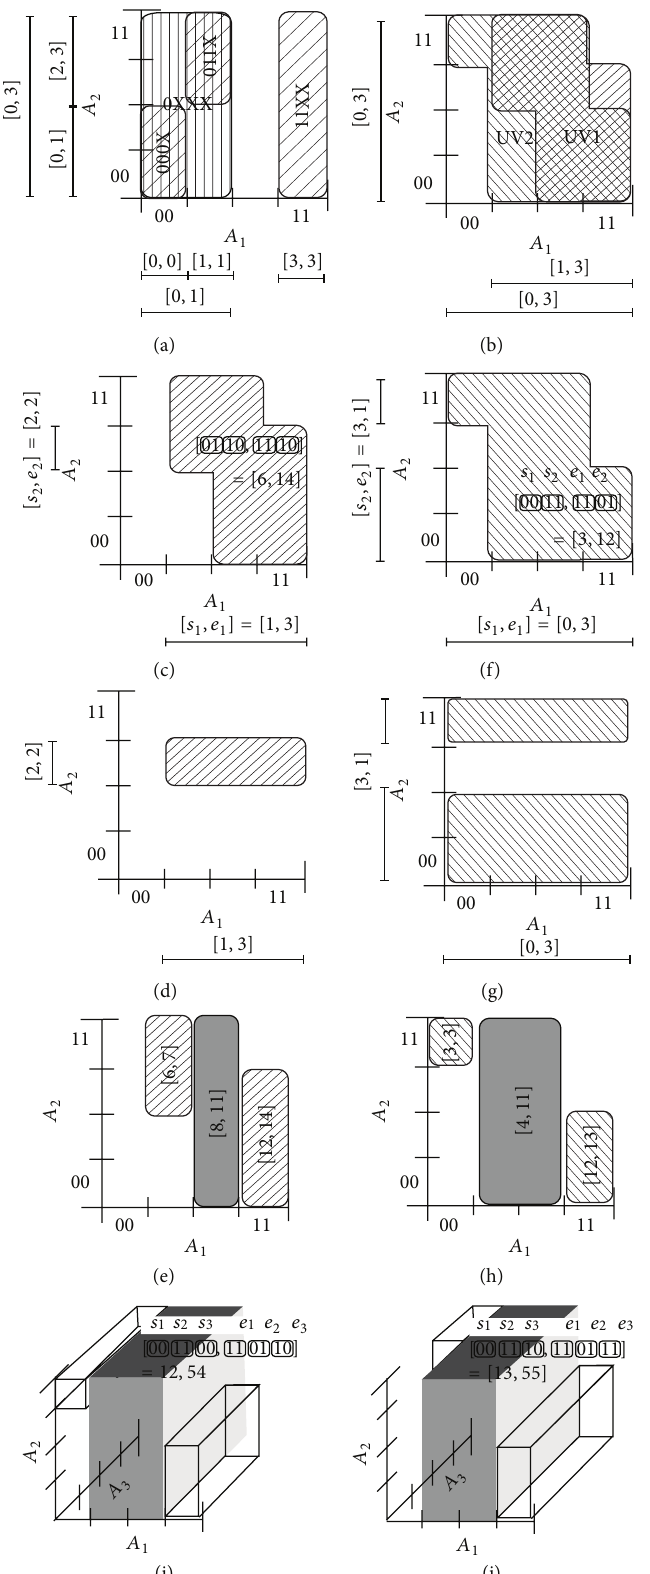
Figure 15: Stitched ERM: (a) PX ruleset, (b) AR ruleset, (c), (d), and (e) AR where 𝑠 2 < 𝑒 2 , (f), (g), and (h) AR where 𝑠 2 > 𝑒 2 , and (i) and (j) extension of (h) to 3